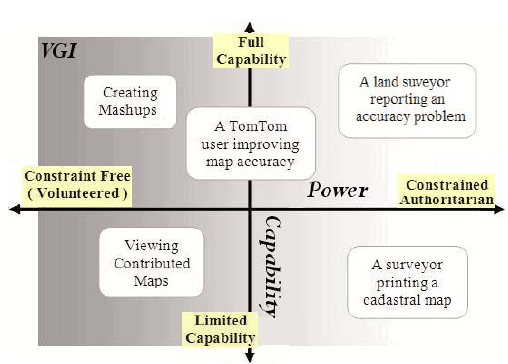
Figure 51: from Grira et al (2009), volunteer freedom of interaction compared with authoritarian constraint.